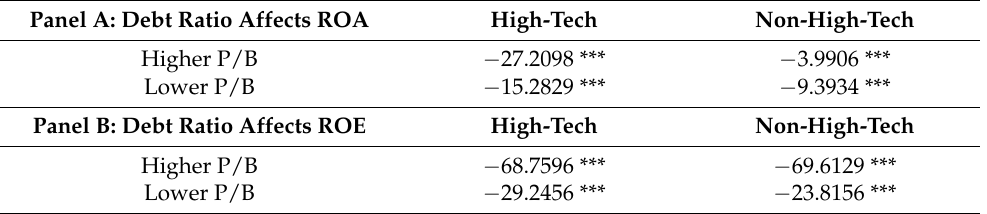
Table 5. Impact of debt ratio on ROA and ROE of high-tech and non-high-tech businesses. Panel A: Debt Ratio Affects ROA High-Tech Non-High-Tech Higher P/B − 27.2098 *** − 3.9906 *** Lower P/B − 15.2829 *** − 9.3934 *** Panel B: Debt Ratio Affects ROE High-Tech Non-High-Tech Higher P/B − 68.7596 *** − 69.6129 *** Lower P/B − 29.2456 *** − 23.8156